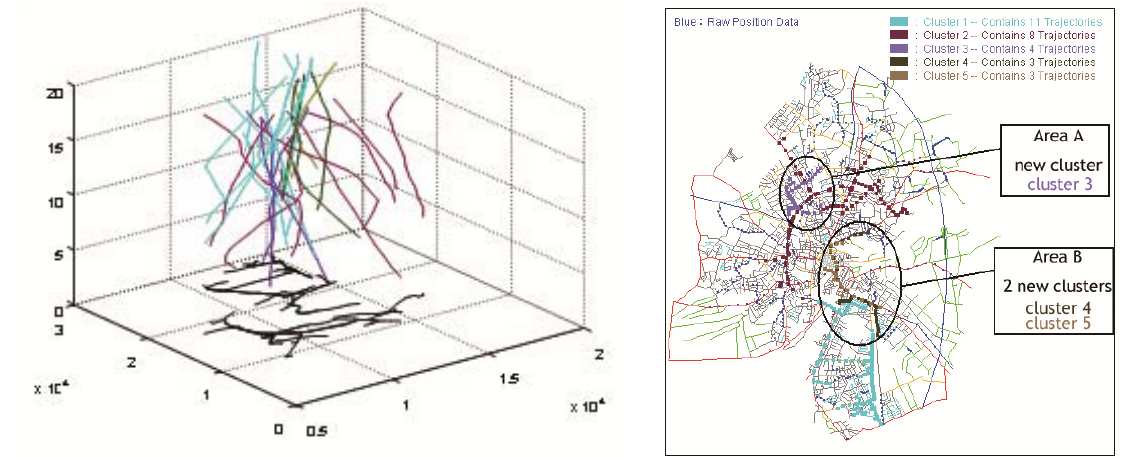
Fig. 9. Trajectory clustering results with proposed spatio-temporal similarity, stops characteristic points are considered during spatio- temporal similarity analysis. (A) is clusters showed in MATLAB, (B) shows clusters in road network